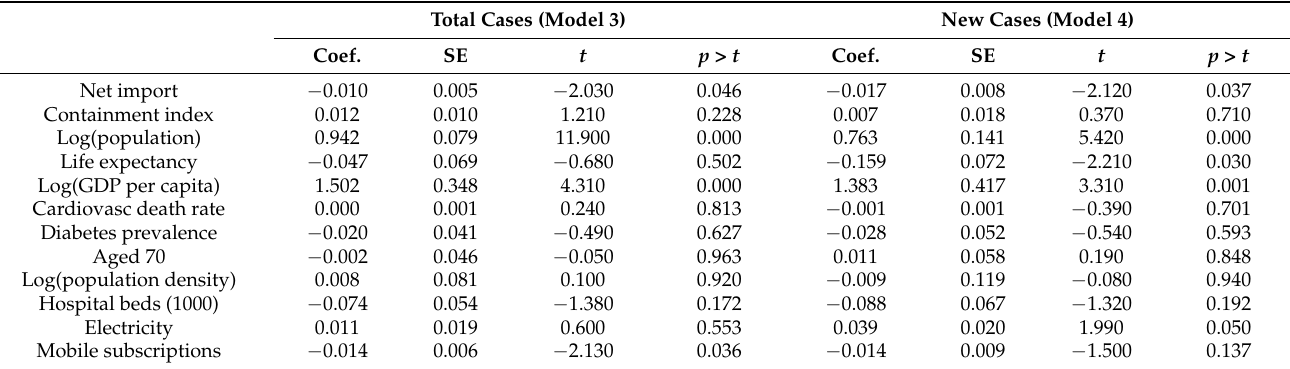
Table 4. Sensitivity analysis: confirmed cases as Covid-19 outcomes.